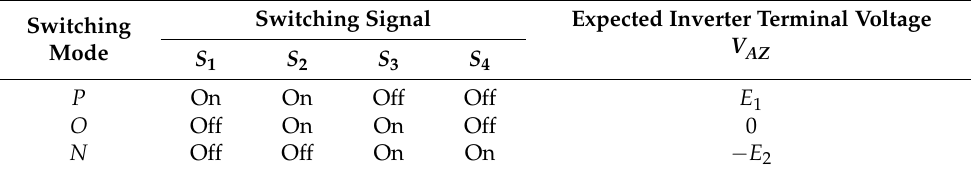
Figure 1. Circuit of a typical NPC three-level inverter. Table 1. Switching mode of the conventional switching method.